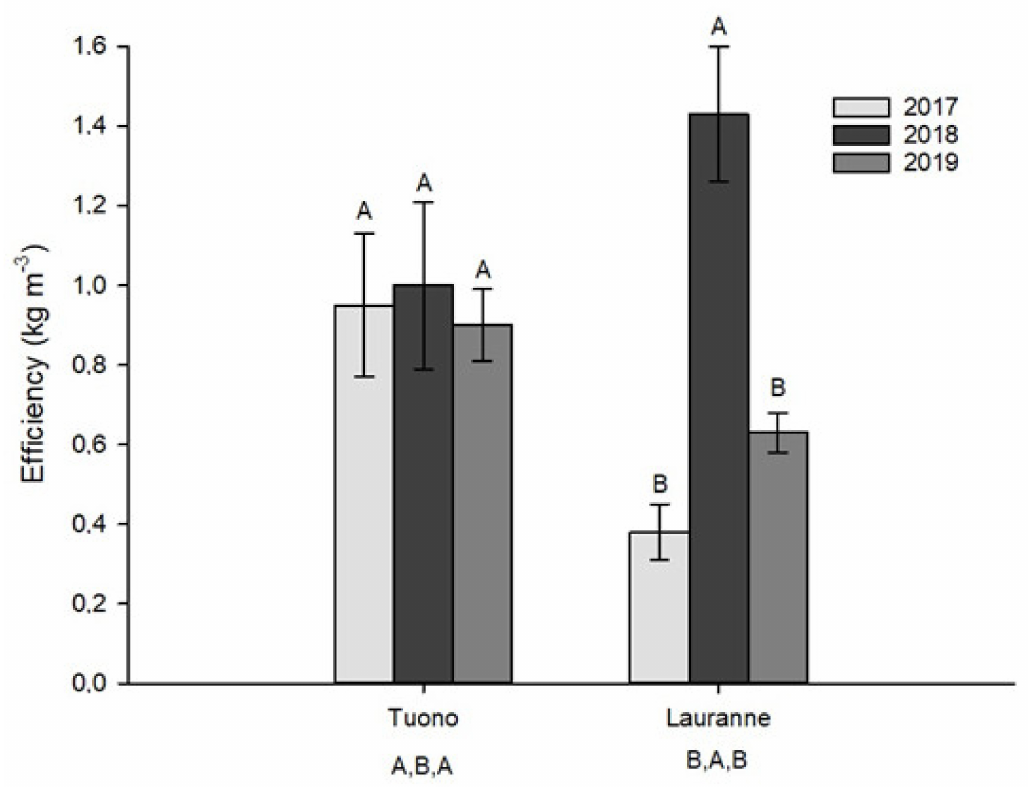
Figure 8. Efficiency on canopy volume (kgm − 3 ) of cultivars Tuono and Lauranne in three subsequent years (2017–2019). The letters on the bars denote statistical differences among years for each cultivar; the letters on the x-axis denote statistical differences between cultivars for each year (SNK test). Lower case letters denote statistical differences at p = 0.05; capital letters denote statistical differences at p = 0.01.